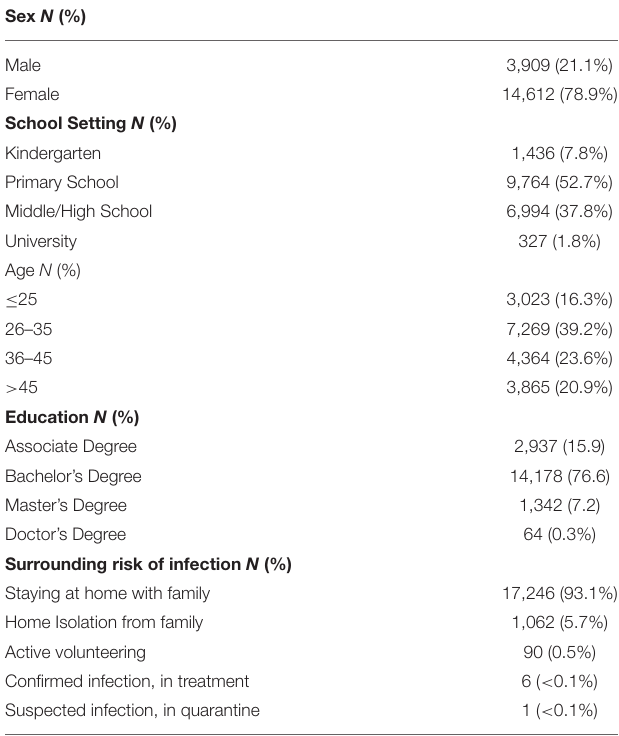
TABLE 1 | Demographic characteristics ( N =